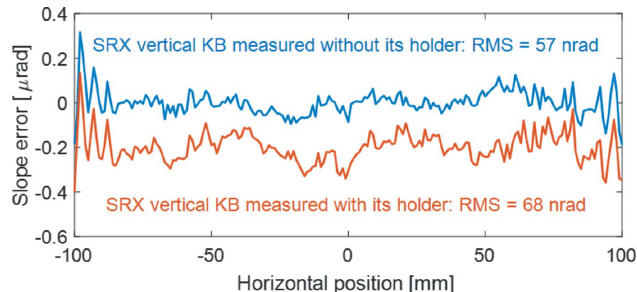
Figure 3 Residual slope errors of the vertical KB are evaluated with best ellipse fitting. The residual slope error is 57 nrad RMS when the mirror is measured without the mirror holder. When the mirror is measured with its holder, the residual slope error slightly increases to 68 nrad RMS. A vertical shift is added for better visualization and